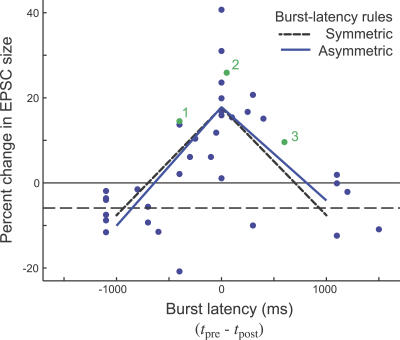
Burst-Time–Dependent Learning Rule at the Retinogeniculate SynapsePercent change in synaptic efficacy evoked by pairings at different latencies between pre- and postsynaptic bursts. The average change for non-overlapping bursts (Figure 2E) is shown as a dashed line. The best symmetric (solid) or asymmetric (dotted) burst-based rules are also shown. The three numbered examples are considered in detail in Figure 4.
t
post, time of the postsynaptic burst; t
pre, time of the presynaptic burst.